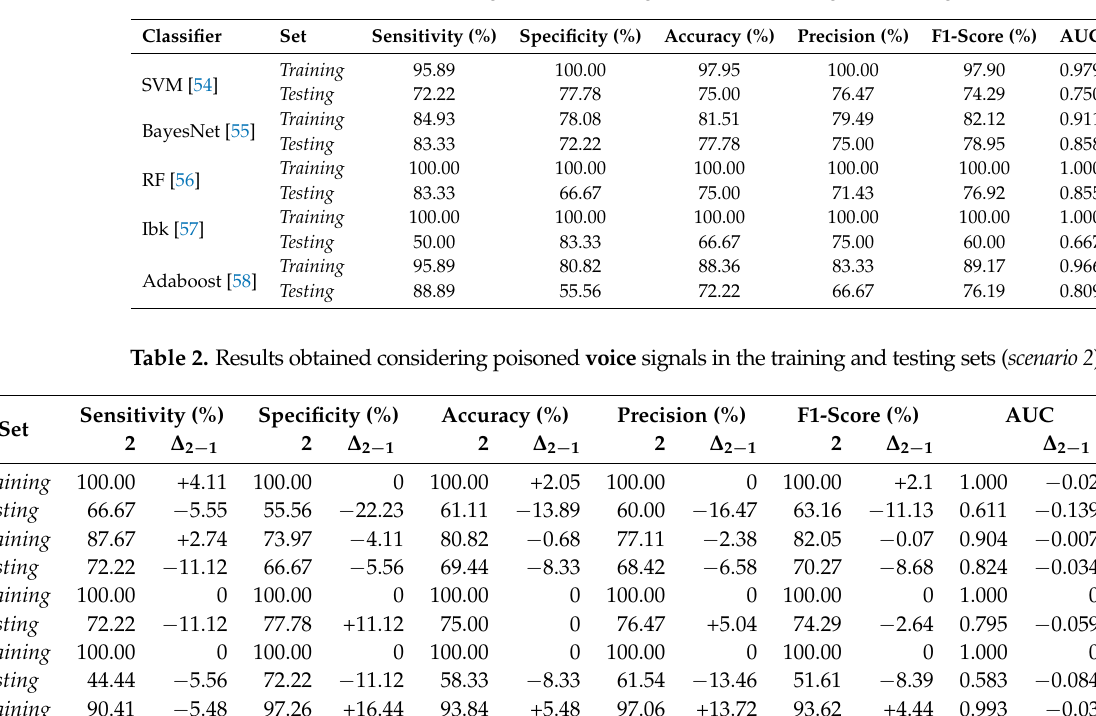
Table 1. Results obtained considering clean voice signals in the training and testing sets ( scenario 1 ).